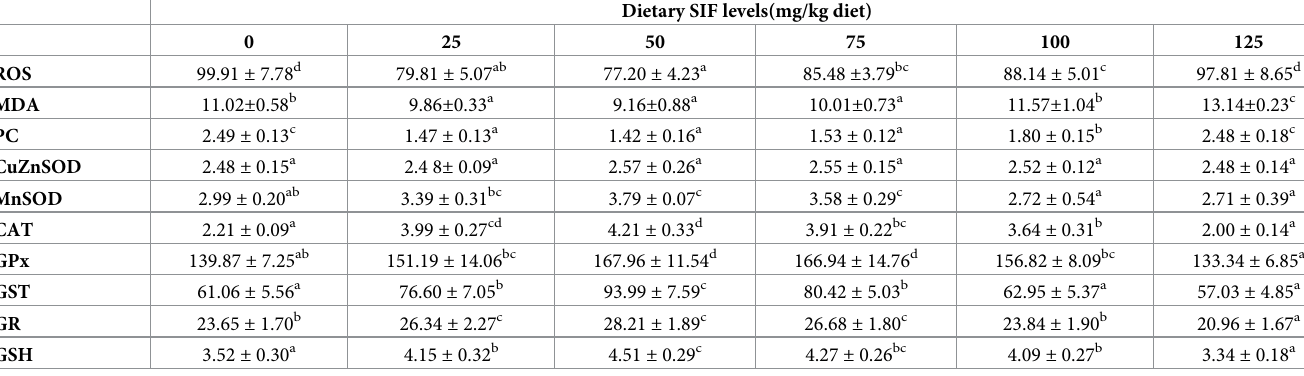
Table 7. Effects of dietary SIF supplementation (mg/kg) on antioxidant parameters in the muscle of grass carp 1 .